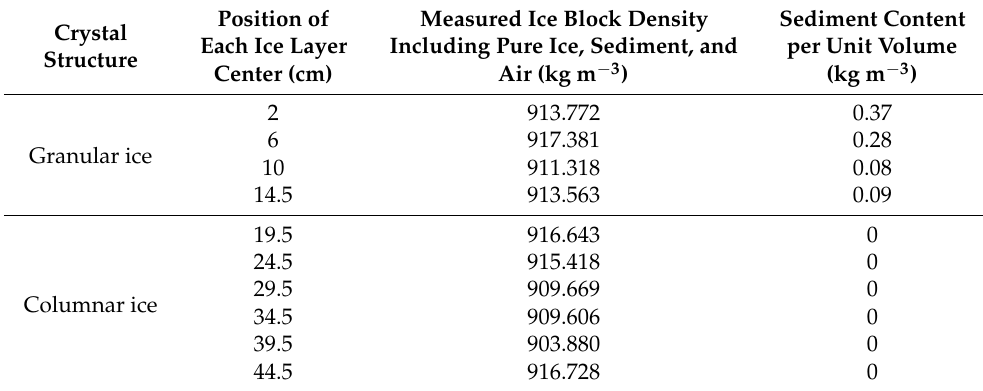
Table 1. Position of test center, mixture density, and sediment content of granular and columnar ice in the ice sample.